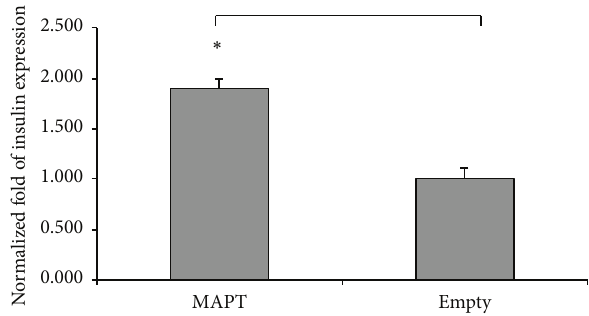
Figure 6: RT-qPCR of RNA isolated from Rin-5F. Ins1 gene expression in MAPT overexpressing ( 𝑛 = 4 ) versus Empty cell line ( 𝑛 = 4 ) was evaluated using the ΔΔ CT method; 𝑝 < 0.05 .